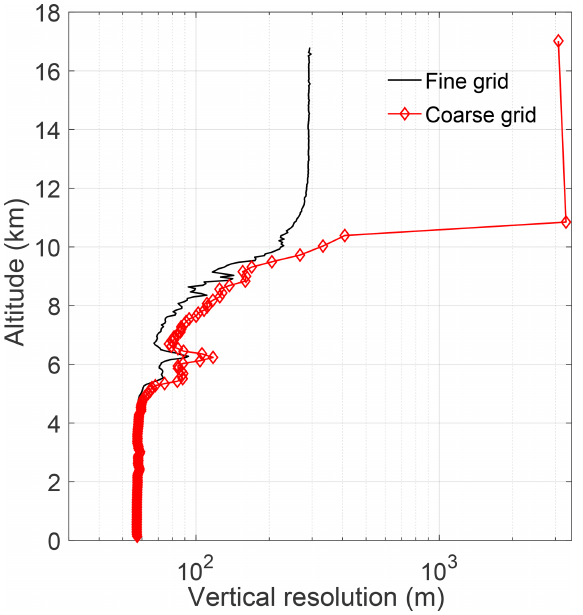
Figure 10. The vertical resolution for 24 April 2013 00:00UT. The vertical resolution on the coarse-grid retrieval decreases as more points are added to ensure that each bin has one degree of freedom. The coarse-grid resolution is shown in red and each point is